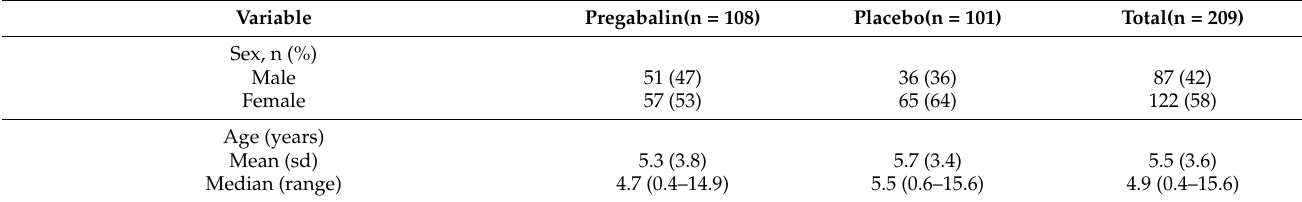
Table 7. Demographic and baseline